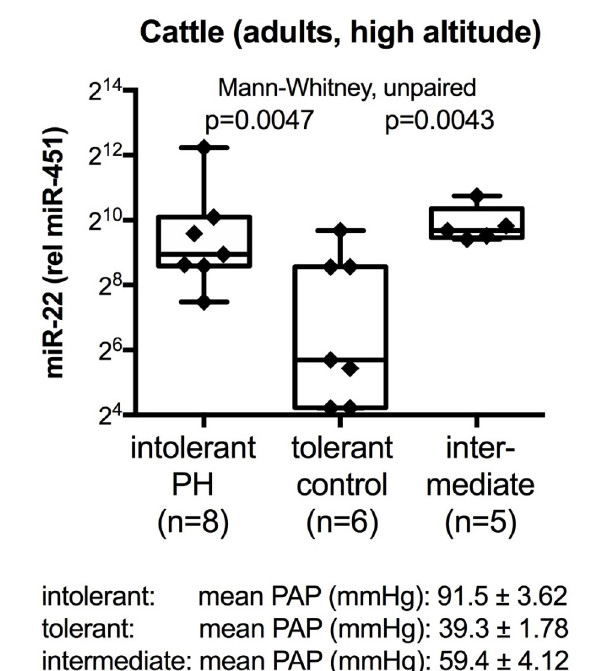
FIGURE 1 | Circulating plasma miRNA values in cattle at high altitude. Box-plots with whiskers and individual points show miR-22-3p relative to miR-451a (10,000 × ) values in plasma samples from control cattle that were tolerant to high altitude [mean pulmonary artery pressure, mean PAP, < 50 mm Hg (Newman et al., 2015)], or that developed PH (mean PAP ≥ 79 mmHg), or that had intermediate mean PAP. Groups were compared with the unpaired, 2-tailed Mann–Whitney test; p < 0.05 was considered